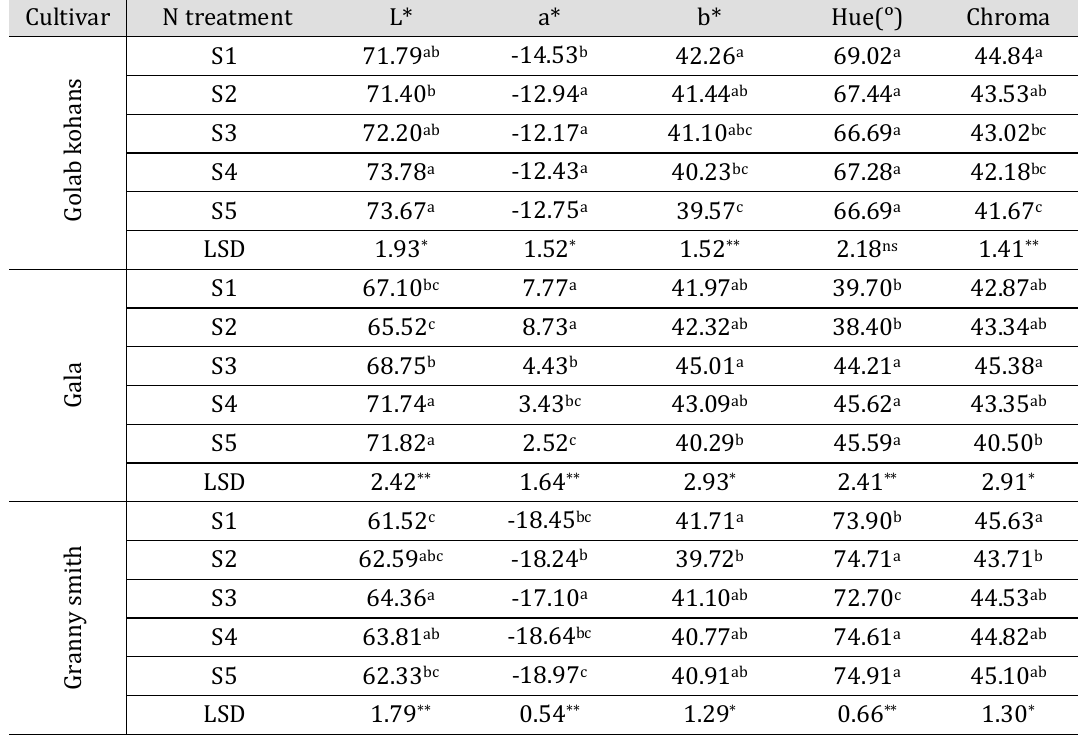
Different letters in each column for each cultivar mean significant difference. LSD interpretation (ns: non- significant, *: significant at the 0.05 level and **: significant at the 0.01 level). Table 4. The effect of various levels of ammonium to total nitrogen in nutrition solutions on apple fruit color of three apple cultivars (Golab Kohans, Gala and Granny Smith) during storage